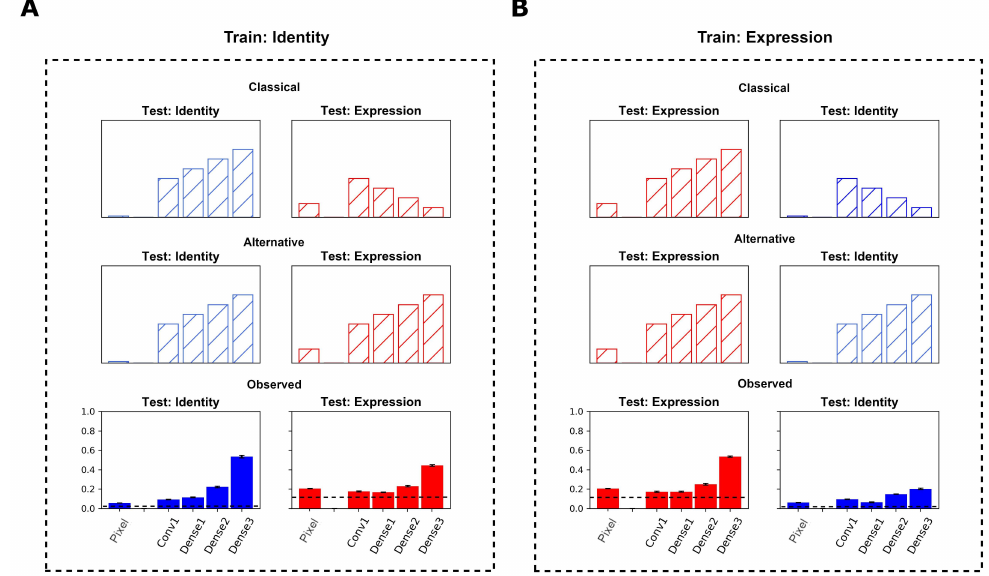
Figure 4. Identity and Expression Networks. ( A ) Identity Network. (Top row) Expected pattern of results following a classical view of abstraction. (Middle row) Expected pattern of results following an alternative view of abstraction. (Bottom row) Observed Results. Classification accuracy for identity (left) and expression (right) for a readout layer attached to successive sections of the pre- trained identity network. Dotted line represents performance at chance. Leftmost bar represents performance of the unattached linear classifier. ( B ) Expression Network. (Top row) Expected pattern of results following a classical view of abstraction. (Middle row) Expected pattern of results following an alternative view of abstraction. (Bottom row) Observed Results. Classification accuracy for expression (left) and identity (right) for a readout layer attached to successive sections of the pre- trained expression network. Dotted line represents performance at chance. Leftmost bar in each plot represents performance of the unattached linear classifier. Error bars denote the SEM of the performance of each network